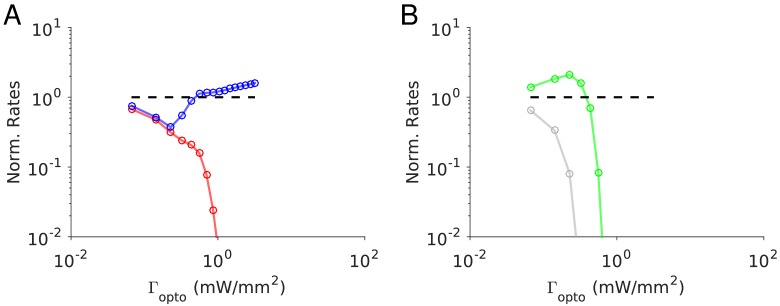
Model 1 for JEE<JEE∗.Proportionality of the PC and PV activity requires fine-tuning. (A) The response of the PV population is paradoxical for small Γopto and is proportional to the PC response. (B) Responses of the SOM and VIP neurons. Baseline firing rates: rE = 6.4 Hz, rI = 12.2 Hz, rS = 6.5 Hz, rV = 11.0 Hz. Color code as in Figure 7. Interaction parameters: JE0 = 40 µA. ms.cm-2; JEE = 20 µA. ms.cm-2; JEI = 32 µA. ms.cm-2; JES = 22 µA. ms.cm-2; JEV = 0; JI0 = 31 µA. ms.cm-2; JIE = 36 µA. ms.cm-2; JII = 30 µA. ms.cm-2; JIS = 20 µA. ms.cm-2; JIV = 0;JSE = 26 µA. ms.cm-2; JSI = 0; JSS = 0; JSV = 12 µA. ms.cm-2; JV0 = 22 µA. ms.cm-2; JIE = 28 µA. ms.cm-2; JVI = 24 µA. ms.cm-2; JVS = 12 µA. ms.cm-2; JVV = 0; . Other parameters as in Tables 3.